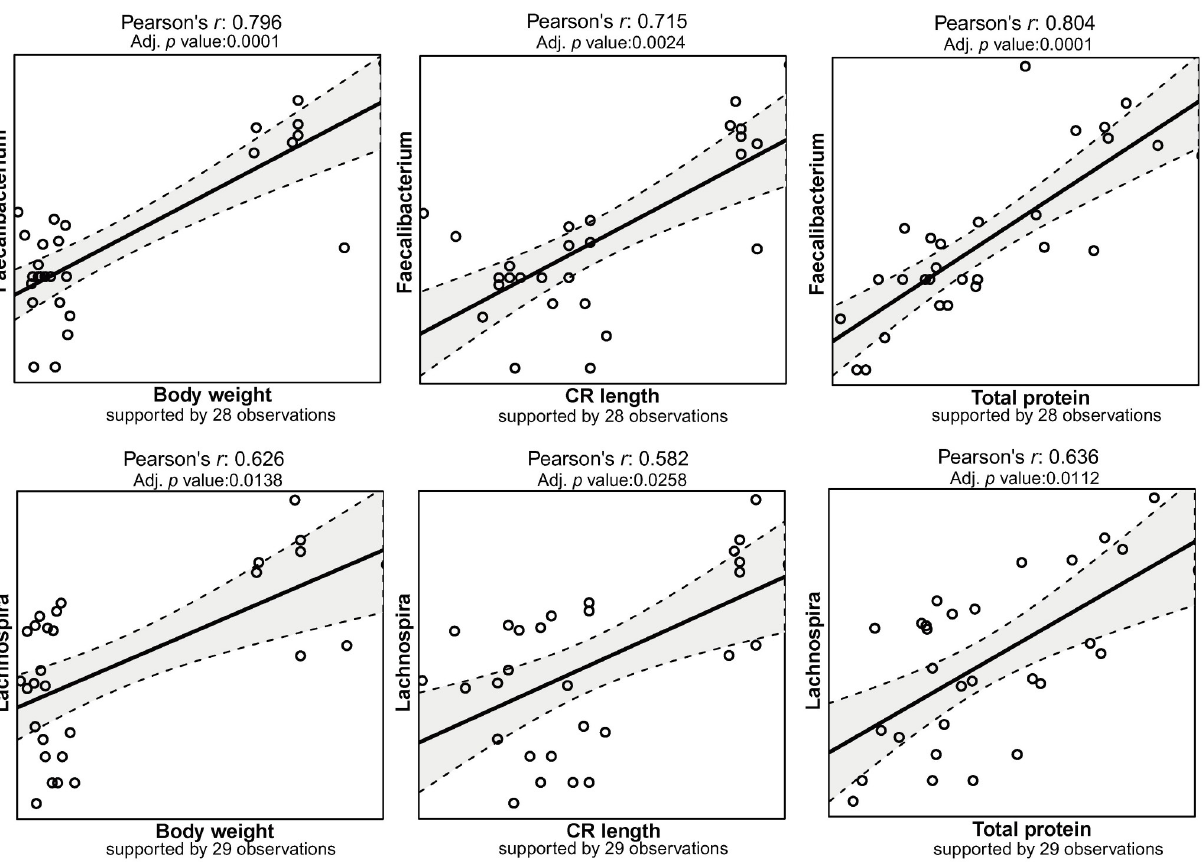
Fig 5. The Pearson’s correlation matrix between host body development and the abundance of Faecalibacterium and Lachnospira . The observation number indicated the number of samples included in the correlation analysis. Zeros in taxonomic abundance were treated as missing values. Samples with missing values were excluded for the correlation